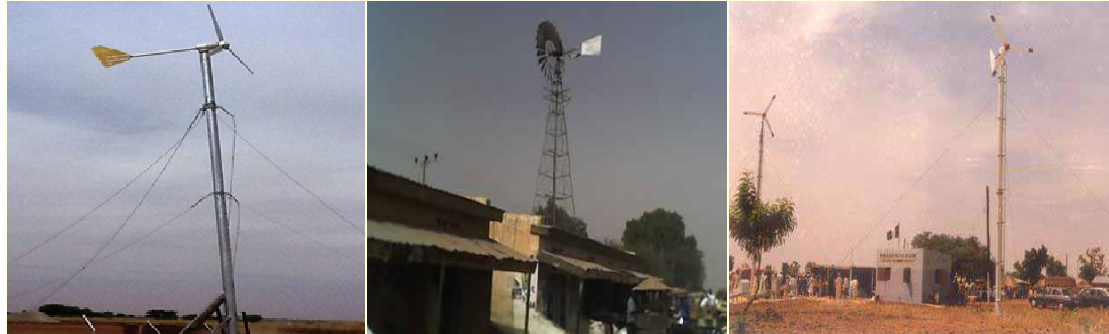
Figure 8. Wind turbines in some parts of Nigeria (from left to right ): in Danjawa, in Kadawa and in Sayya, Gidan Gada [55,56].